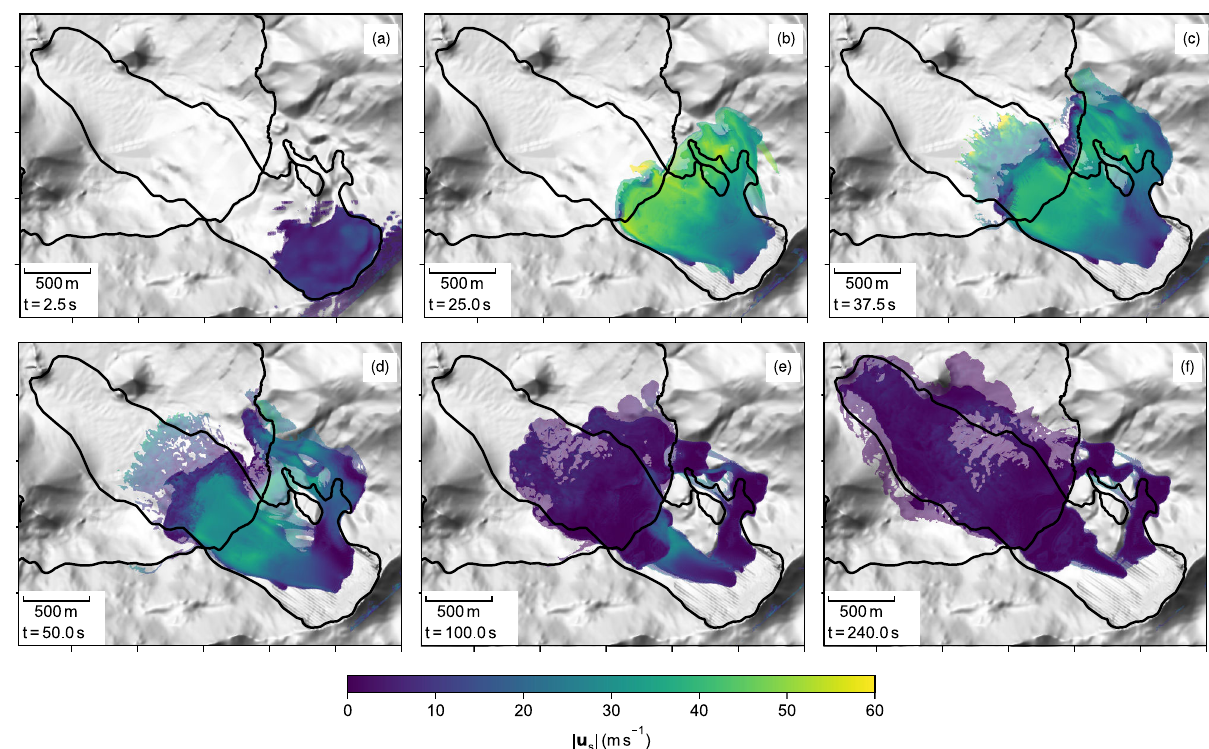
Fig. 5 The simulated Lake Askja landslide. a – f The dense core of the slide is represented by the ϕ g = 0.25 iso-surface and the surrounding dilute particle cloud by the ϕ g = 0.01 iso-surface. The colour shows the particle velocity and the dilute cloud is shown transparently. The black lines show the lake shoreline and the documented avalanche path for reference. For an animated version see supplemented movies 1 and